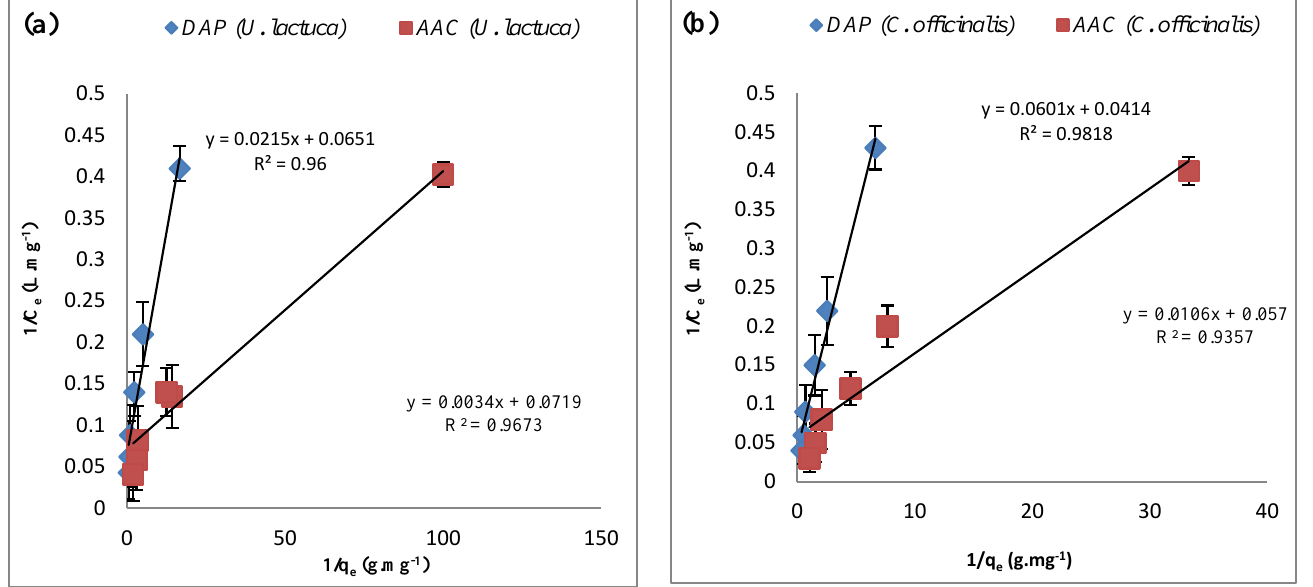
Figure 8. ( a , b ). Langmuir adsorption isotherms for Fe +3 on DAP and AAC of ( a ) Ulva lactuca ( b ) Corallina officinalis . Each